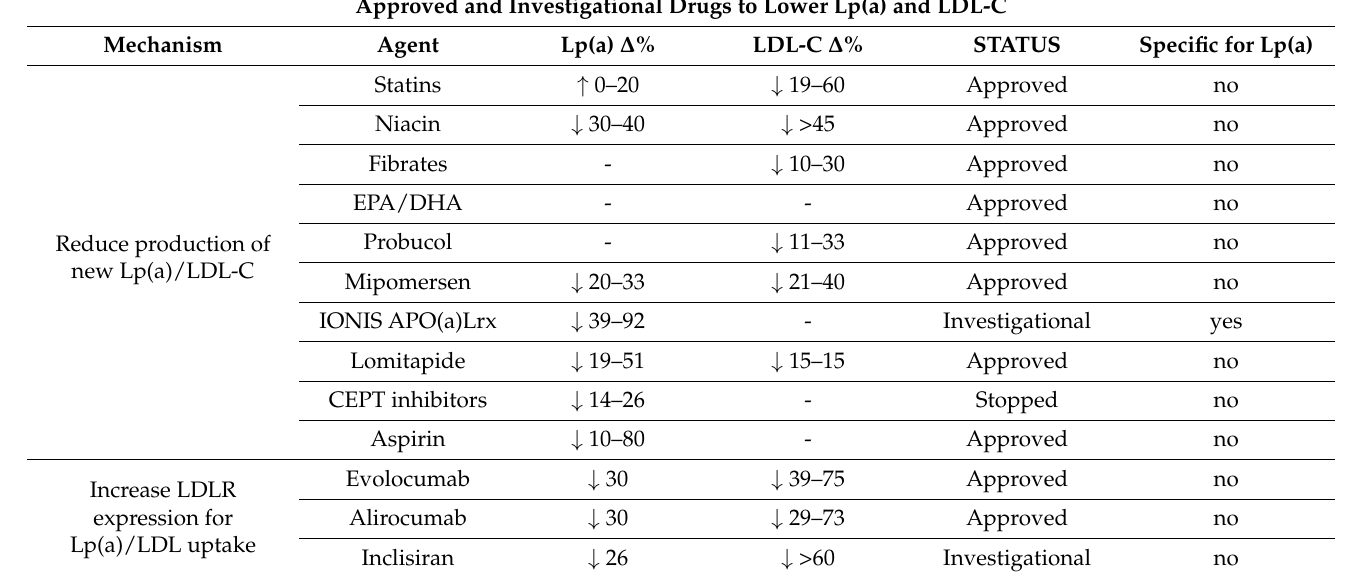
Table 1. Summary of approved or investigational therapeutic drug to lower Lp(a) and LDL-C. Approved and Investigational Drugs to Lower Lp(a) and